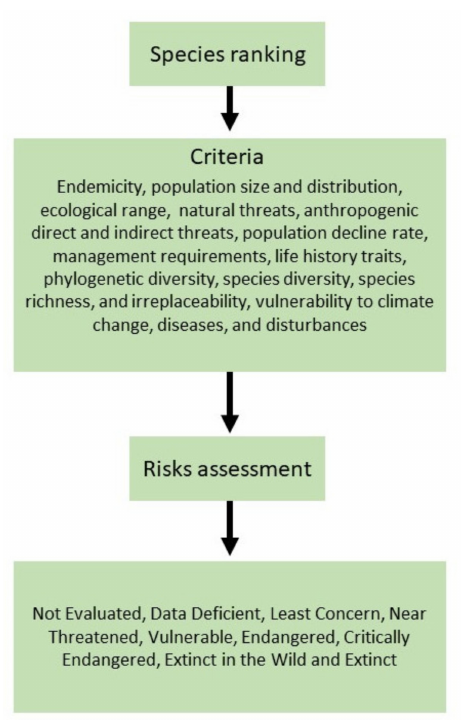
Figure 7. Criteria and categories used for prioritizing conservation action using the conservation status rank